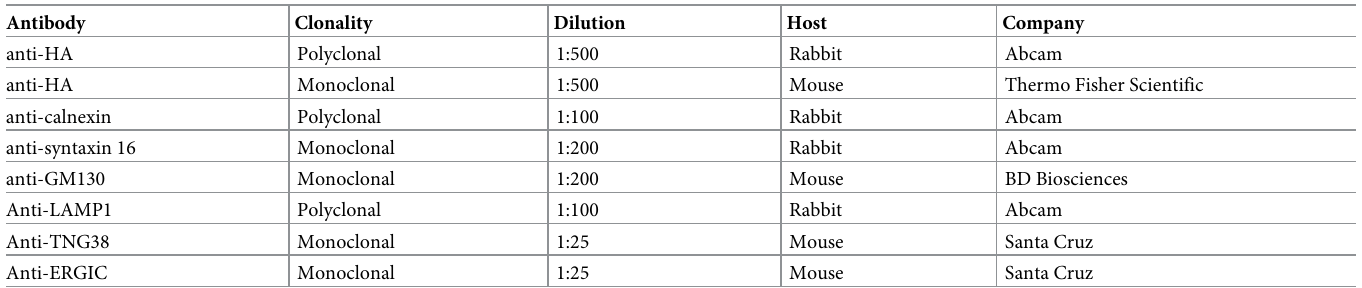
Table 3. List of primary antibodies used for immunofluorescent analysis.